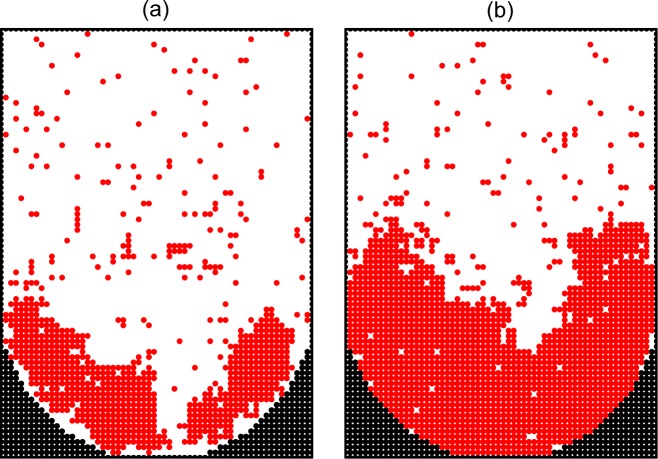
Monte Carlo simulation of cell proliferation and spheroid formation in the microwells.Cross sections of a well along the main axis at ϑ = 0.2 (a) and 0.4 (b) in the absence of cell-surface adhesion (ϵcs = 0). Cell diffusion is relatively rapid (pdiv = 10−4). In addition, the gravity is taken into account (ϵg = –0.03).